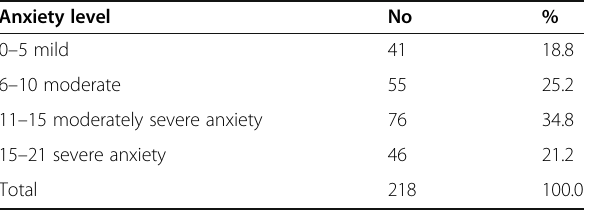
Table 2 Total score of General Anxiety Disorder (GAD-7) among studied subjects ( n =